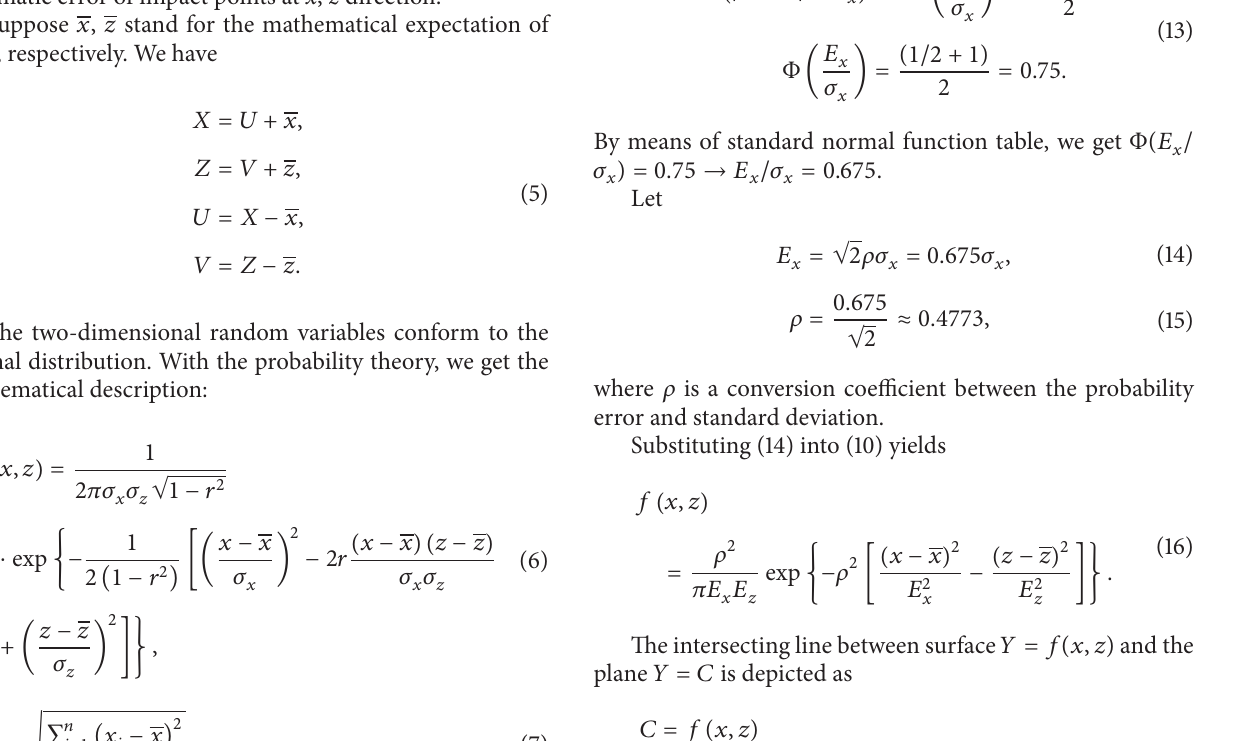
systematic error of impact points at x , z